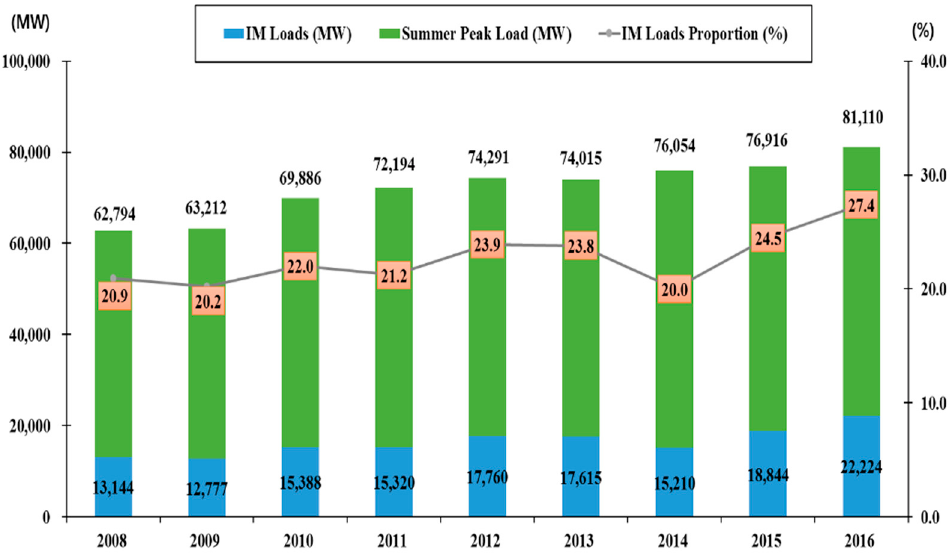
Figure 3. IM load proportion at summer peak condition.